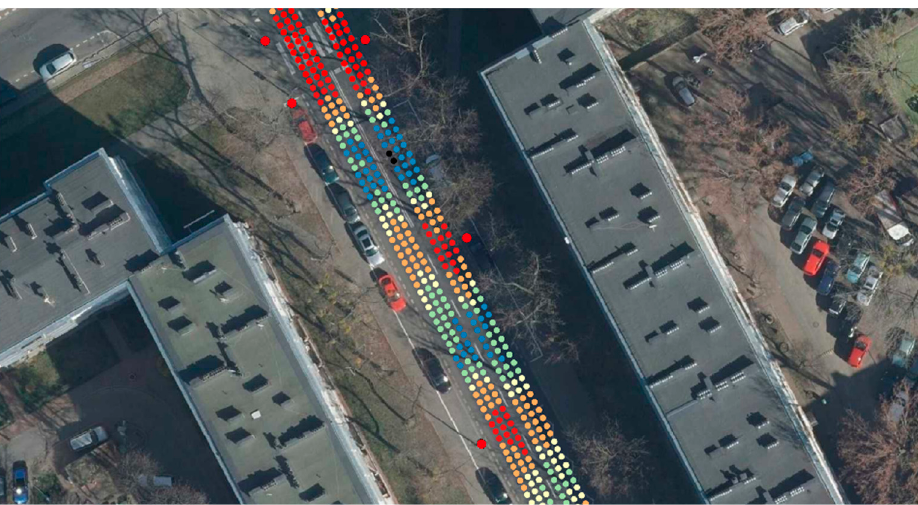
Figure 9. Illuminance measurements on representative Section 24.